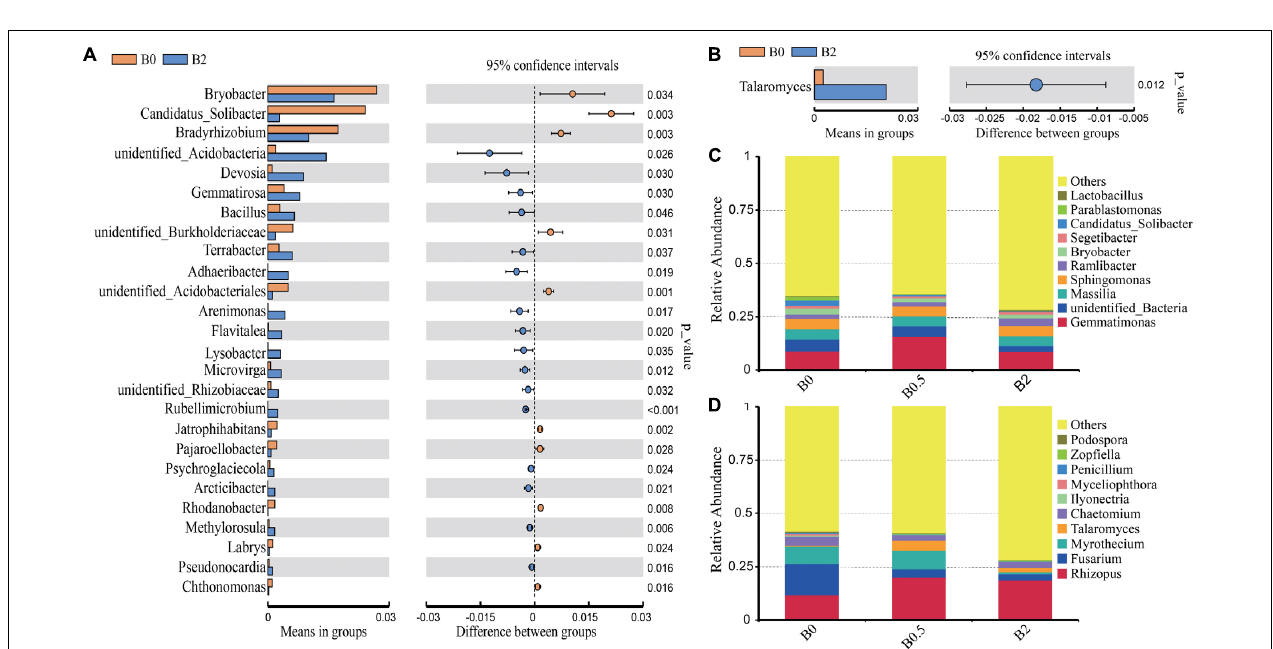
FIGURE 5 | The relative abundances of bacteria and fungi at the genus level. Panels (A,B) showed the dominant (relative abundances > 0.1%) bacterial and fungal genera with significant differences of the relative abundances between treatments without biochar amendment and with biochar amendment at the concentration of 2% based on Welch’s t- test ( P < 0.05; n = 3); (C,D) shows the relative abundances of top 10 main bacterial and fungal genera, respectively.